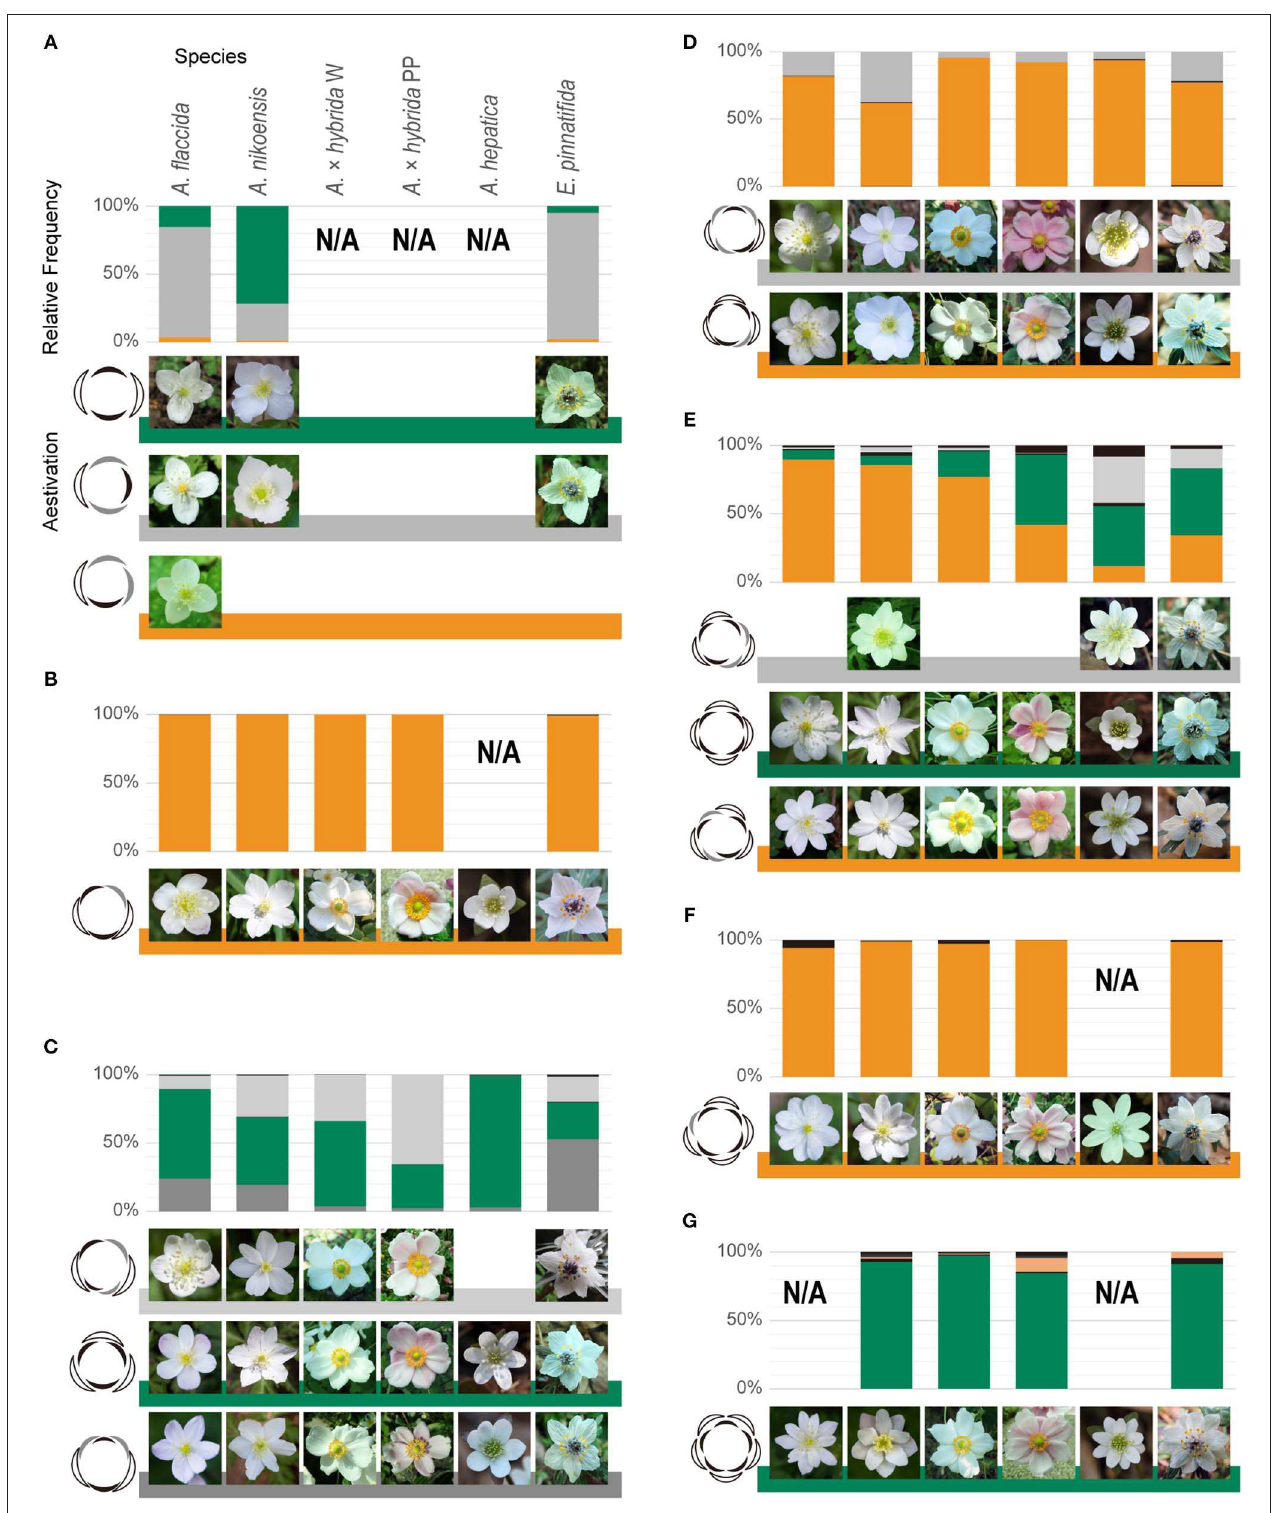
FIGURE 2 | Constrained, intraspecific coexistence of whorled and spiral flowers. Relative frequency of aestivation in flowers with 4 (A) , 5 (B) , 6 (C) , 7 (D) , 8 (E) , 9 (F) , and 10 (G) tepals. Green and orange in bar charts denote double-whorled and spiral flowers, respectively, and dark and light gray denote other aestivations,